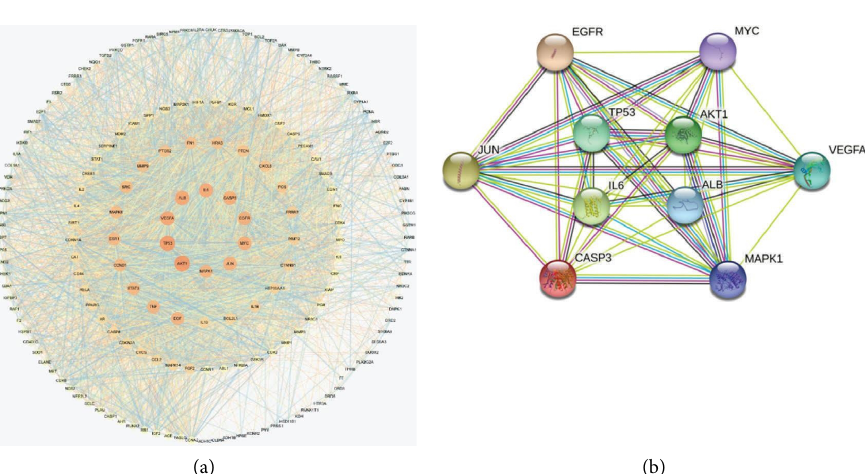
Figure 4: Protein-protein interaction of expression genes: (a) the combination of all types of expression genes and (b) 10 high-degree gene